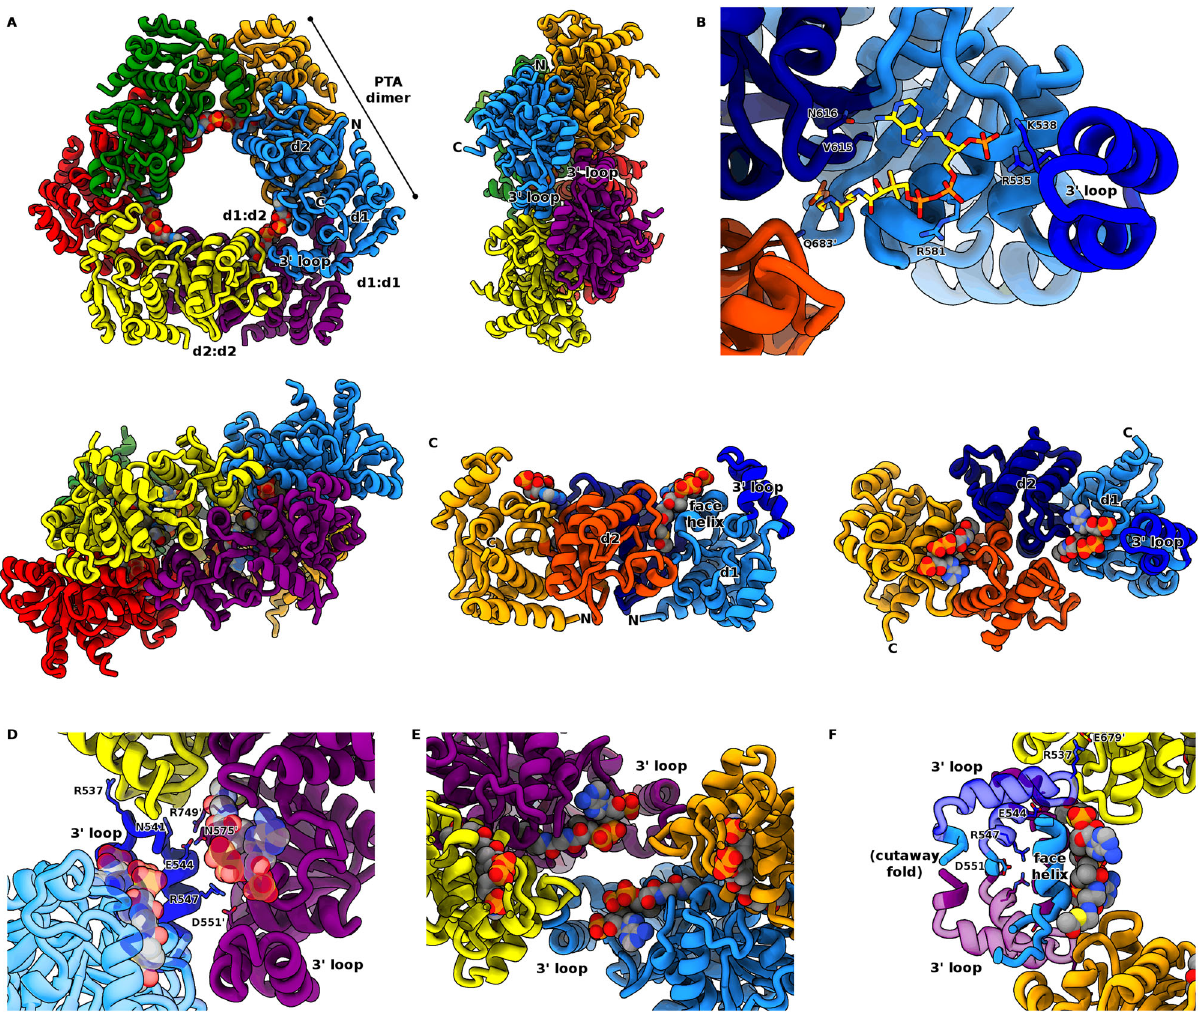
Fig. 3 Structure of the MaeB PTA hexamer and interactions with acetyl-CoA. A Structural features of the D3 MaeB PTA hexamer, viewed from front, side and edge orientations. The classical PTA dimer (e.g. orange and blue protomers) trimerizes to give d1:d1, d2:d2 and d1:d2 interfaces. The N-terminal connection to the (missing) ME domain is situated at the hexamer long edge. B Interaction of the MaeB PTA domain with the regulatory acetyl-CoA ligand (yellow). A helical motif, which we term the 3 ′ loop (R535 and K538), interacts at the ligand 3 ′ phosphate. C Features of the PTA dimer unit (from two orthogonal views), which associates around the d2:d2 interface, and binds two molecules of acetyl-CoA at the d1:d2 cleft. D , E Involvement of the 3 ′ loop in forming the trimer interface, acetyl-CoA shown in vdw form. Two 3 ′ loops form the inner “ cradle ” at the d1:d1 interface, such that two acetyl-CoA binding sites come into close contact between separate dimers. F Cutaway view of the d1 face helix forming a fl at surface for